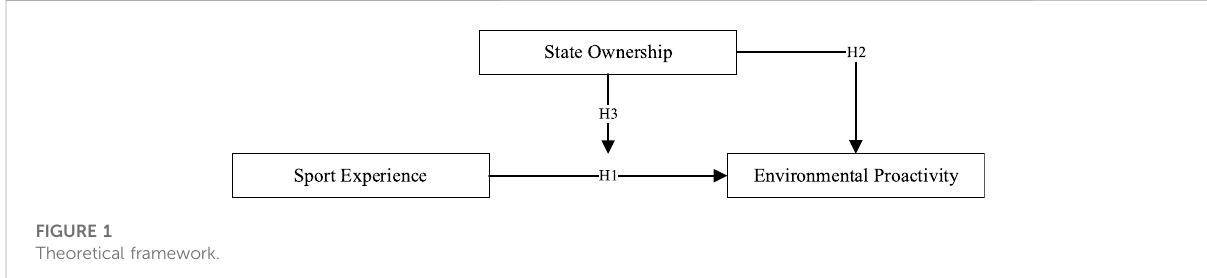
FIGURE 1 Theoretical